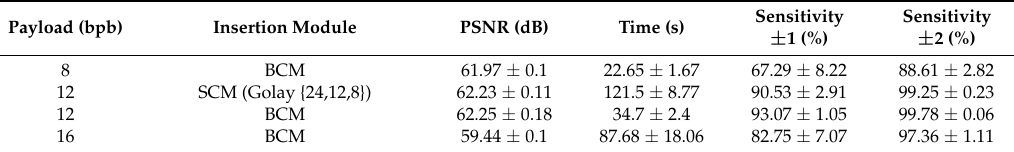
Table 1. Results for some settings of Quaternion Karhunen-Lo è ve Transform Fragile Watermarking (QKLT-FW) (the best performances with regard to the parameter are highlighted in boldface). Payload (bpb) Insertion